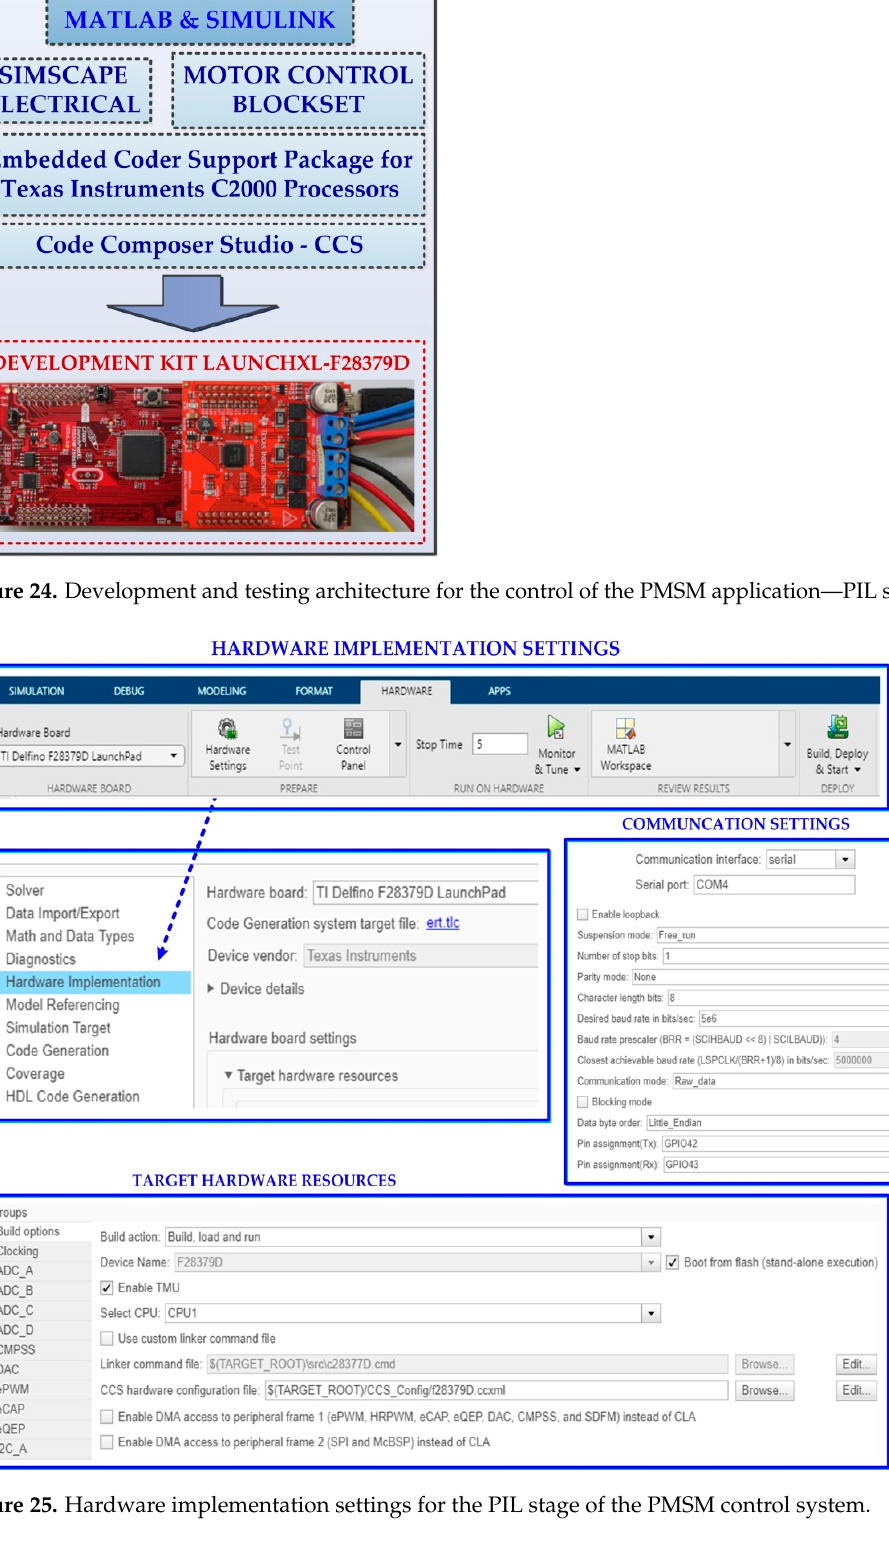
Figure 26. Generate and build code of the control software algorithm subsystem.